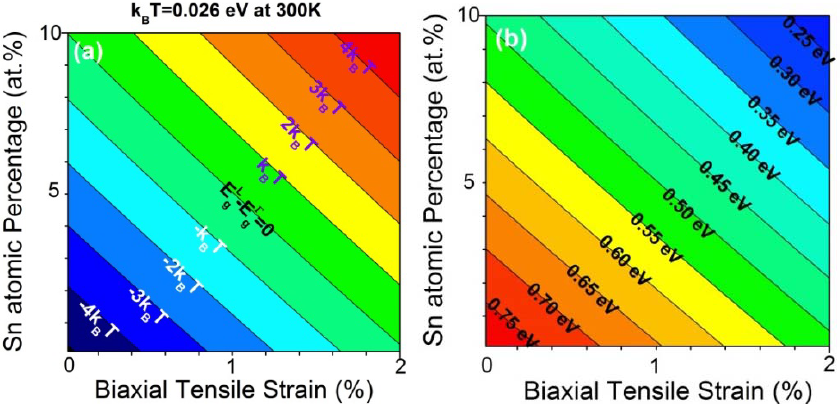
Figure 3. ( a ) Energy difference between the indirect and direct gap, ( E gL − E function of biaxial tensile strain and Sn atomic percentage; ( b ) Direct band gap E a function of biaxial tensile strain and Sn atomic